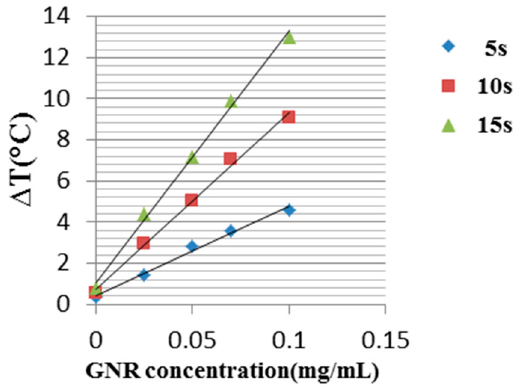
Figure 4. Temperature change as a function of GNRs concentration for three different illuminations times: 5, 10 and 15 s.